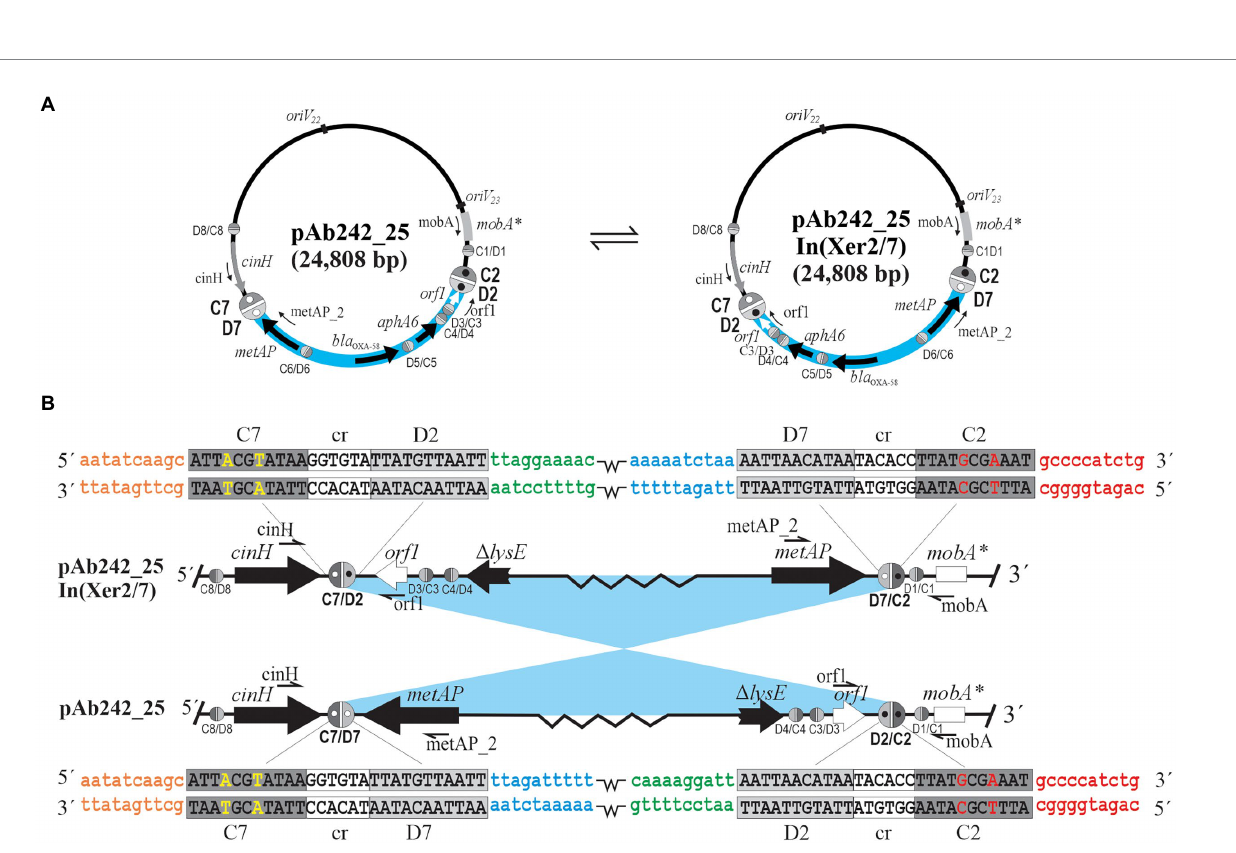
FIGURE 2 DNA inversions resulting from site-specific recombination between oppositely-oriented sister pairs of pXerC/D sites located at the borders of bla OXA-58 -and aphA6 -containing adaptive modules in Acinetobacter plasmids. (A) SSR between the oppositely-oriented sister pair formed by the C2/D2 and C7/D7 sites located in plasmid pAb242_25 mediate the reversible inversion of the intervening sequences between them, thus generating a structural variant designated here as pAb242_25 In(Xer2/7). In turn, the reverse SSR reaction between the resulting oppositely-oriented C2/D7 and C7/D2 “hybrid” sites can regenerate the original pAb242_25 structure. These two structural variants co-exist in clonal populations of the A. baumannii strains analyzed, as well as in clonal populations of other Acinetobacter strains transformed with plasmids carrying the adaptive module present in these A. baumannii strains. The DNA region carrying the bla OXA-58 - and aphA6 -containing RM is highlighted in pale blue, with the orientation of the genes indicated in each case. The different pXerC/D- like recognition sites are indicated as ovals (not drawn to scale), with the C and D binding regions depicted as dark and light gray semi-ovals, respectively. The active sister pairs mediating inversions have been arbitrarily enlarged, and additional open and closed inner circles within have been incorporated to facilitate visualization of the recombinatorial events. The PCR primers used to identify the presence of specific pXerC/D sites (see Supplementary Table S1 for details) are indicated. The oriV22 and oriV23 rectangles denote the location of the iteron regions of the two different replication modules predicted in these plasmids. (B) Enlarged vision of the SSR reactions conducing to the reversible inversions described above. The lowercase colored letters show the DNA sequences located at the immediate vicinities of each specific half-site forming the pXerC/D core (10 bp each), and have been included to facilitate visualization of the SSR events. Note that the sequences of the cr and the XerD binding regions are identical for all recombining sites, while the XerC binding regions show some differences between sites (highlighted in uppercase colored letters). The figure is not drawn to